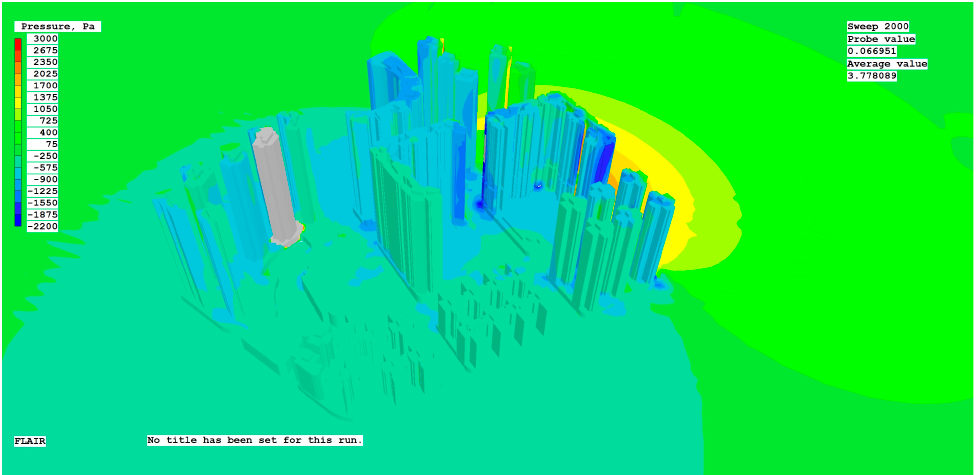
Figure A16. Instantaneous building surface pressure under typhoon conditions (the EDF. Jardim Kong Fok On looks north).